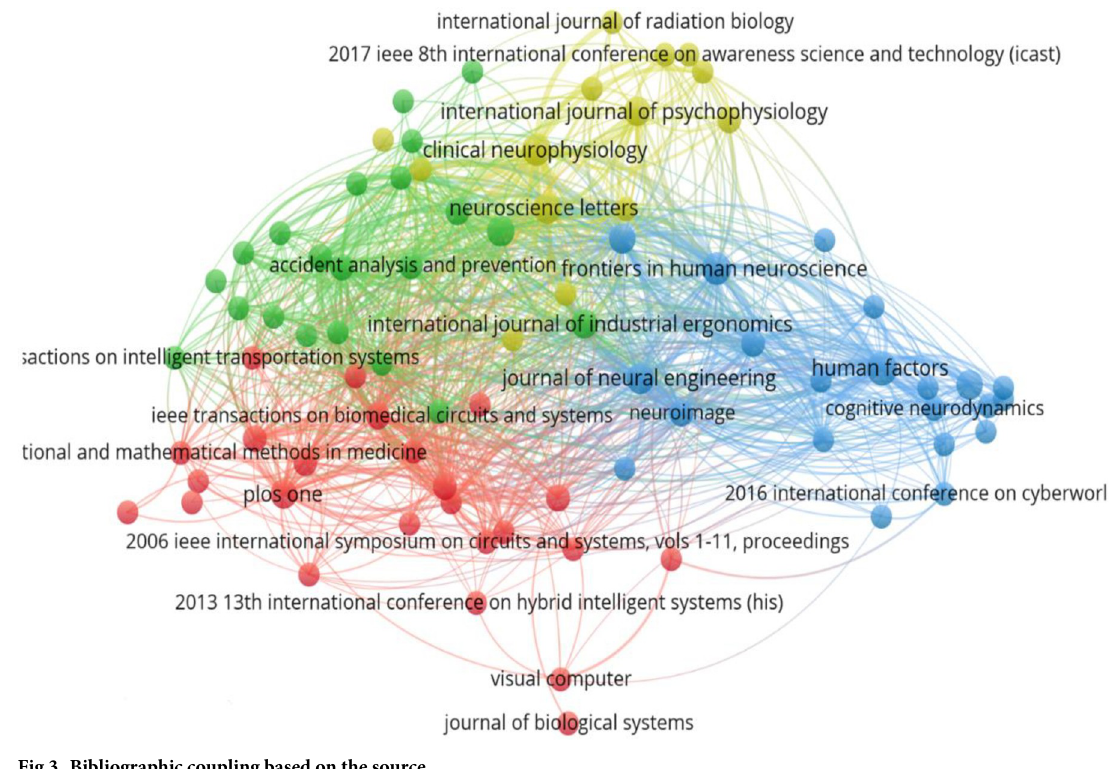
Fig 3. Bibliographic coupling based on the